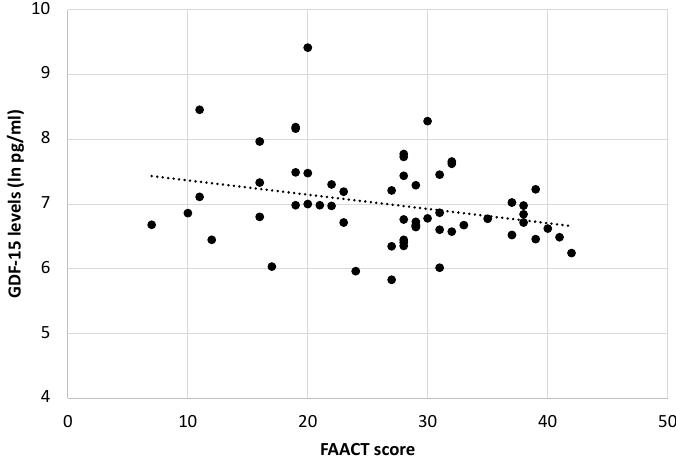
Figure 3. Correlation between the Functional Assessment of Anorexia/Cachexia Therapy (FAACT) score and GDF-15 serum levels (ln pg/mL) (r = − 0.280; p = 0.03). 2.3. GDF-15 Serum Levels in Cancer Patients with Low Muscle Mass vs. Moderate/High Muscle Mass and in Controls The GDF-15 serum levels were significantly higher in patients with low muscle mass (median 6.92, IQR 6.70; 7.37) with respect to controls ( p = 0.0006), as well as higher in pa- tients with moderate/high muscle mass (median 6.76, IQR 6.55; 7.27) compared to control group ( p = 0.0017). However, no differences were found in GDF-15 serum levels between patients with low muscle mass and those with moderate/high muscularity ( p = 0.313) (Figure 4). Among all cancer participants, no correlation was found between GDF-15 se- rum levels and L3-SMI (r = − 0.168, p = 0.203).